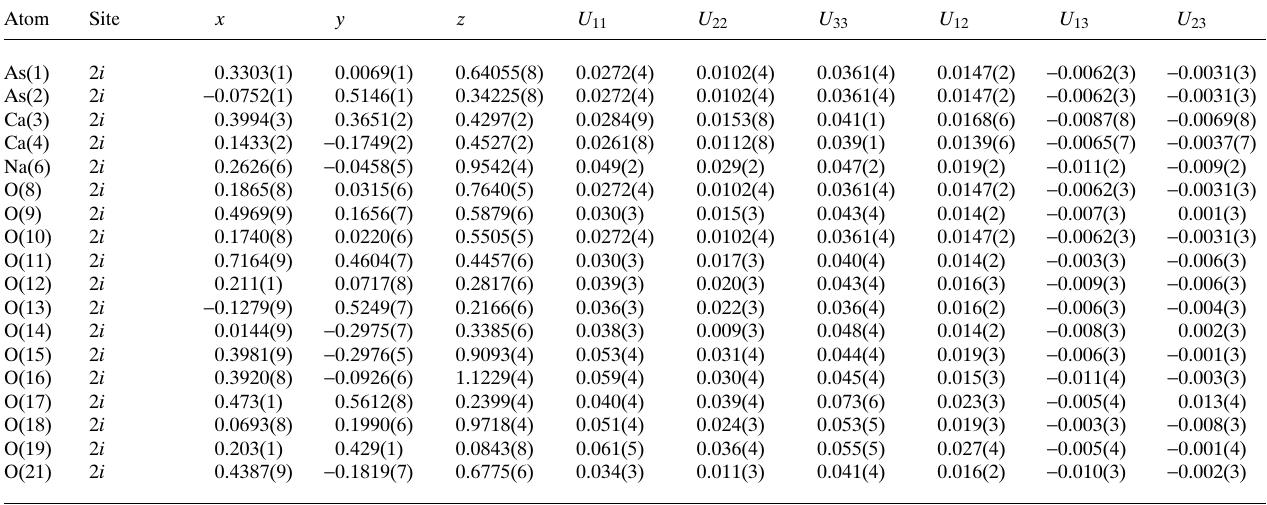
Table 3. Atomic coordinates and displacement parameters (in Å 2 ) .